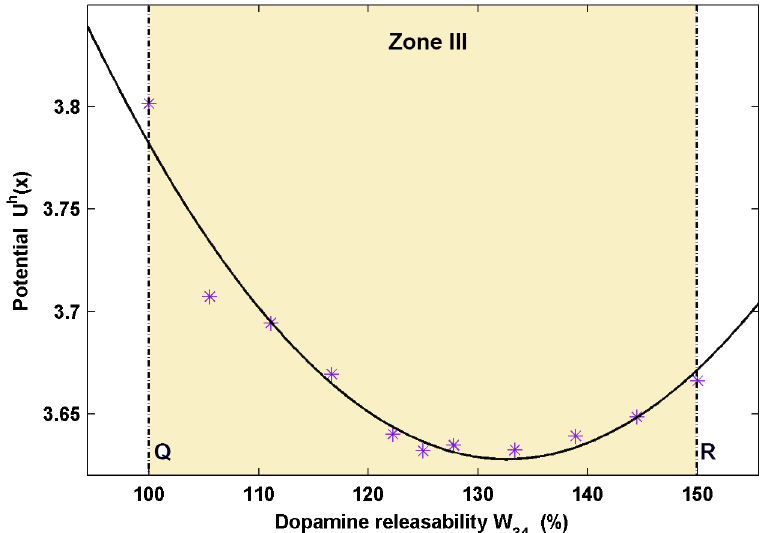
Fig 6. Profile of variation in potential of higher stable state with change in dopamine releasability W 34 . The points shown in asterisks denote the potentials of higher stable states for the respective dopamine releasability, W 34 in zone III obtained from the global potential landscape. The solid curve is a fitting to the data. The potential is minimum in the region between the points Q and R of maximum equilibrium excitatory and inhibitory activities, respectively. The point of minima represents the maximum robustness that the circuit dynamics may achieve during the delay period. This further suggests the existence of a subtle ratio of the equilibrium excitatory to inhibitory activity which fine tunes the circuit ’ s robustness and leads to an inverted-U shaped profile of the robustness of higher stable states during the delay